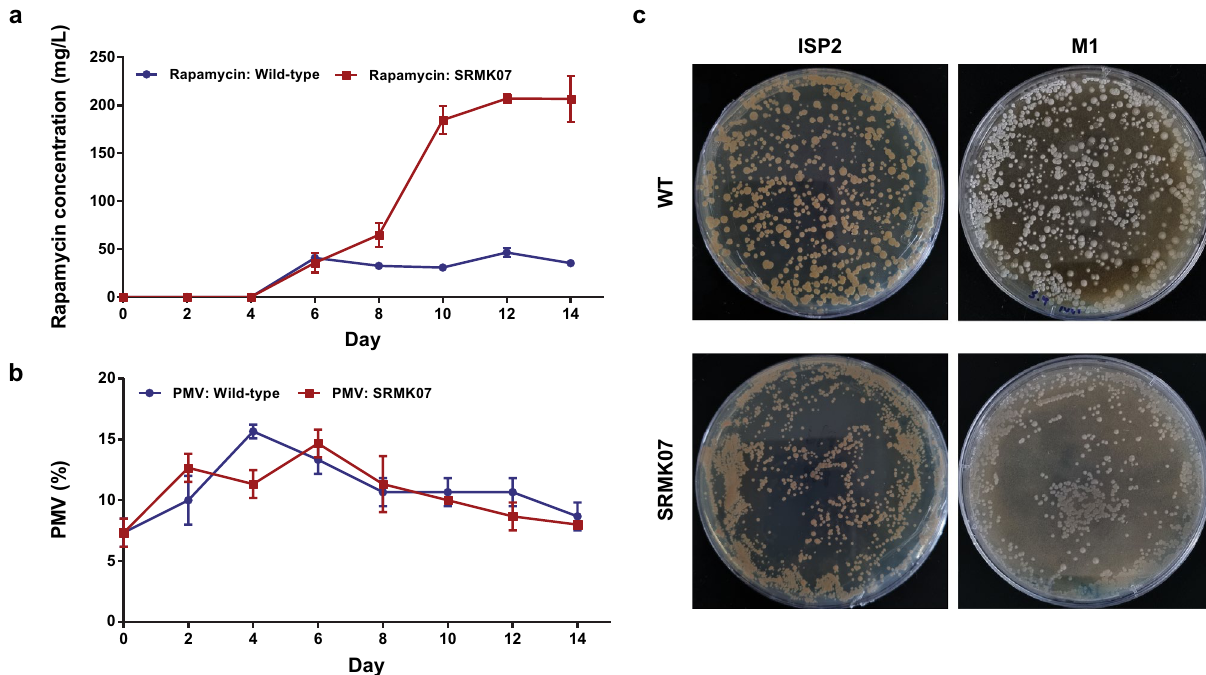
Figure 1. Rapamycin production performance and growth of S. rapamycinicus NRRL 5491 (wild-type) and its rapamycin-overproducing mutant SRMK07. ( a , b ) Rapamycin production performance ( a ) and growth ( b ) of the two strains. The presented data represent the mean from triplicate experiments, and the error bars indicate standard deviations. ( c ) Growth phenotypes of the two strains grown on ISP2 and M1 plates. The wild-type appeared to sporulate on the M1 plate, while the SRMK07 strain did not show any indication of sporulation. Images were taken on the seventh day of